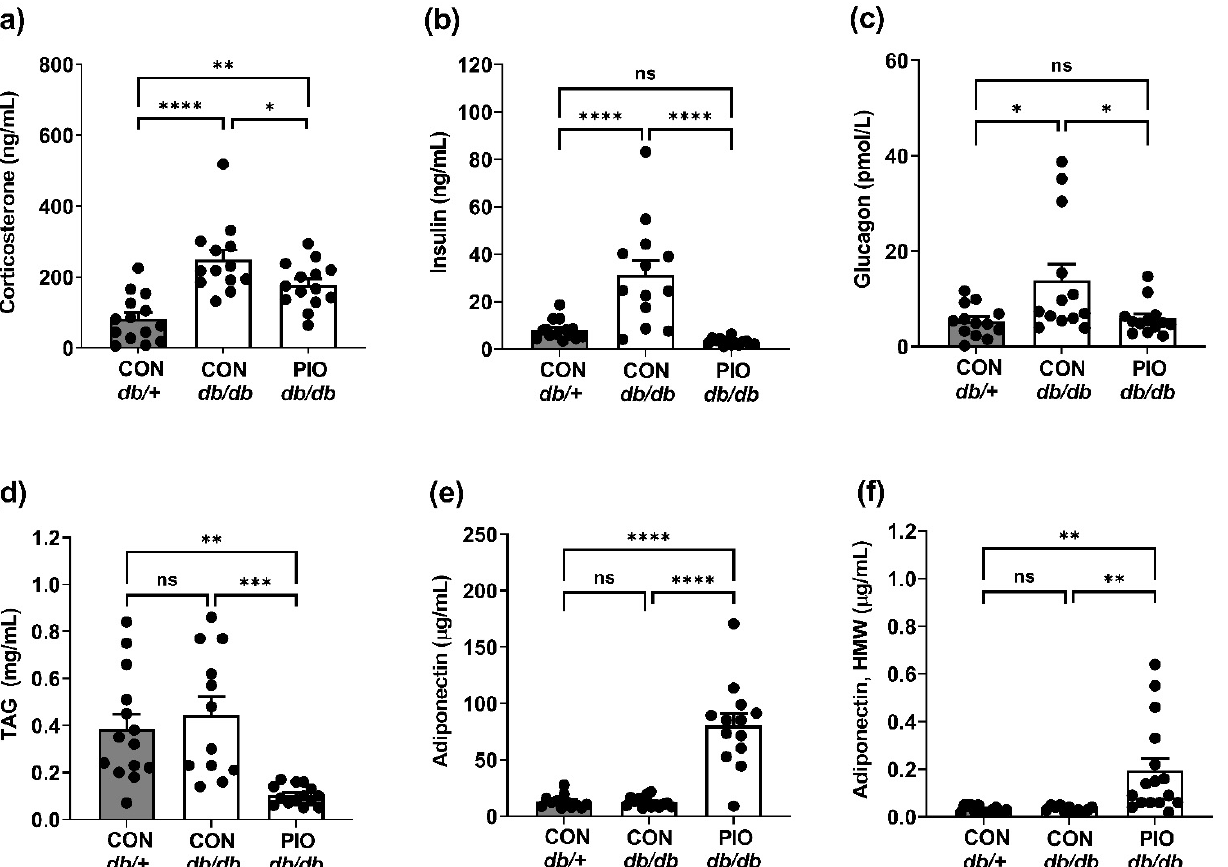
Figure 4. Dietary supplementation of PIO alters circulating levels of endocrine hormones, triglyceride, and adipokines in db/db mice. Serum levels of ( a ) corticosterone, ( b ) insulin, ( c ) glucagon, ( d ) TAG, ( e ) adiponectin, and ( f ) high-molecular- weight (HMW) adiponectin, in db/+ mice on a CON diet (gray bars) and db/db mice on either a CON or PIO-supplemented diet for 28 d (white bars). n = 8 per group. Data are represented as the means ± SEM. * p < 0.05, ** p < 0.01, ***, p < 0.001; **** p < 0.0001. ns, not significant.